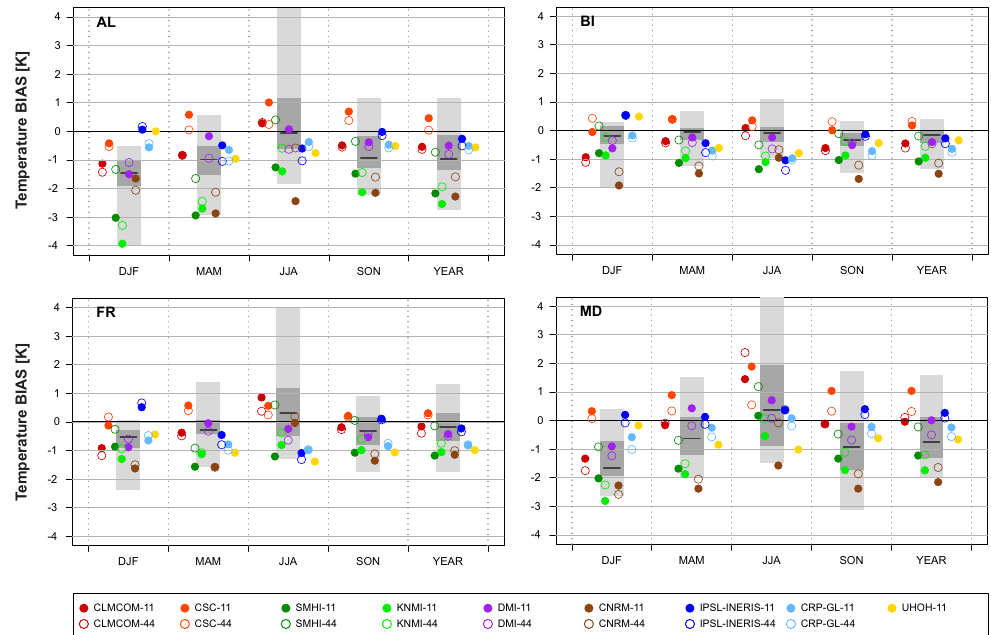
Figure B1. Mean seasonal and annual temperature bias (BIAS; K) for the EUR-11 (filled circles) and the EUR-44 ensemble (open circles) and for subdomains AL, BI, FR and MD (see Fig. 5 for subdomains EA, IP, ME and SC). The gray bars denote the BIAS range of the ENS-22 ensemble: entire range in light gray, interquartile range (corresponding to eight models) in dark gray and median as solid